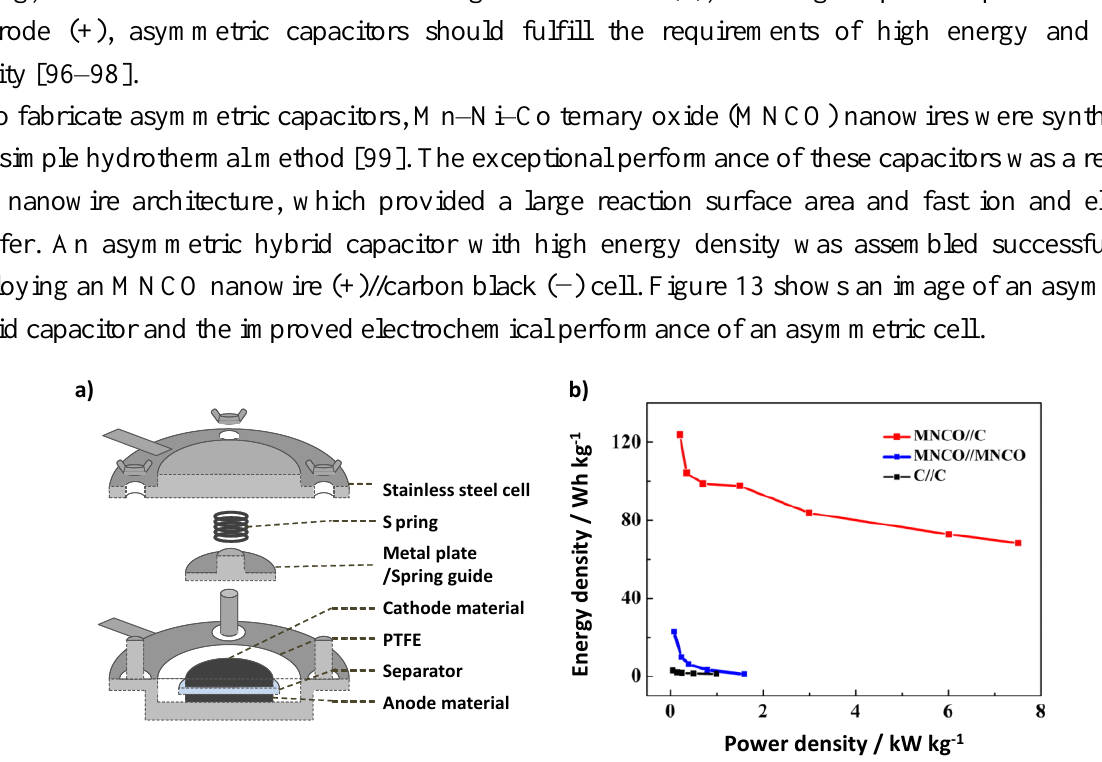
Figure 13. ( a ) Schematic of a representative asymmetric cell. With permission from [100]; Copyright 2014, The Royal Society of Chemistry. ( b ) Ragone plots of the as-fabricated asymmetric MNCO//carbon black, symmetric MNCO//MNCO, and symmetric carbon black//carbon black electrochemical capacitors. With permission from [99]; Copyright 2012, American Chemical